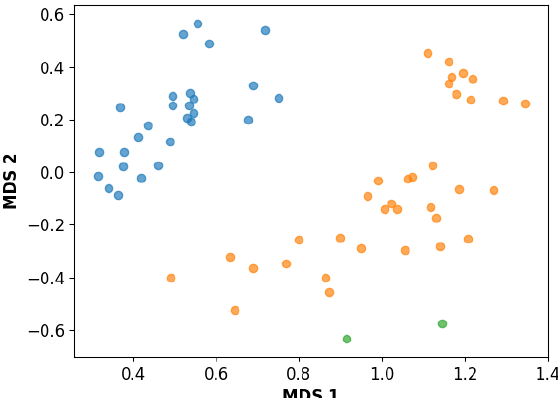
Figure 2. Scatter plot obtained by multidimensional scaling (MDS). The molecules of the G 1 group are shown in blue, the molecules of the G 2 group are shown in orange, and the structural outliers are shown in green.